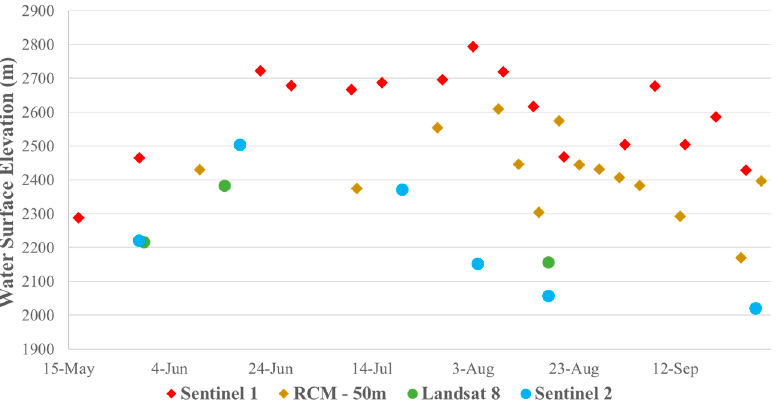
Figure 6. 2020 water surface areas estimated for Sentinel-1, Landsat 8, Sentinel-2 and RADARSAT Constellation instruments.